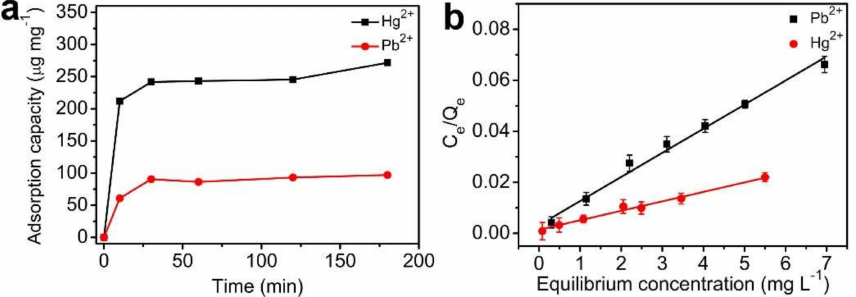
Figure 10. Adsorption kinetic and isotherm of heavy metals on